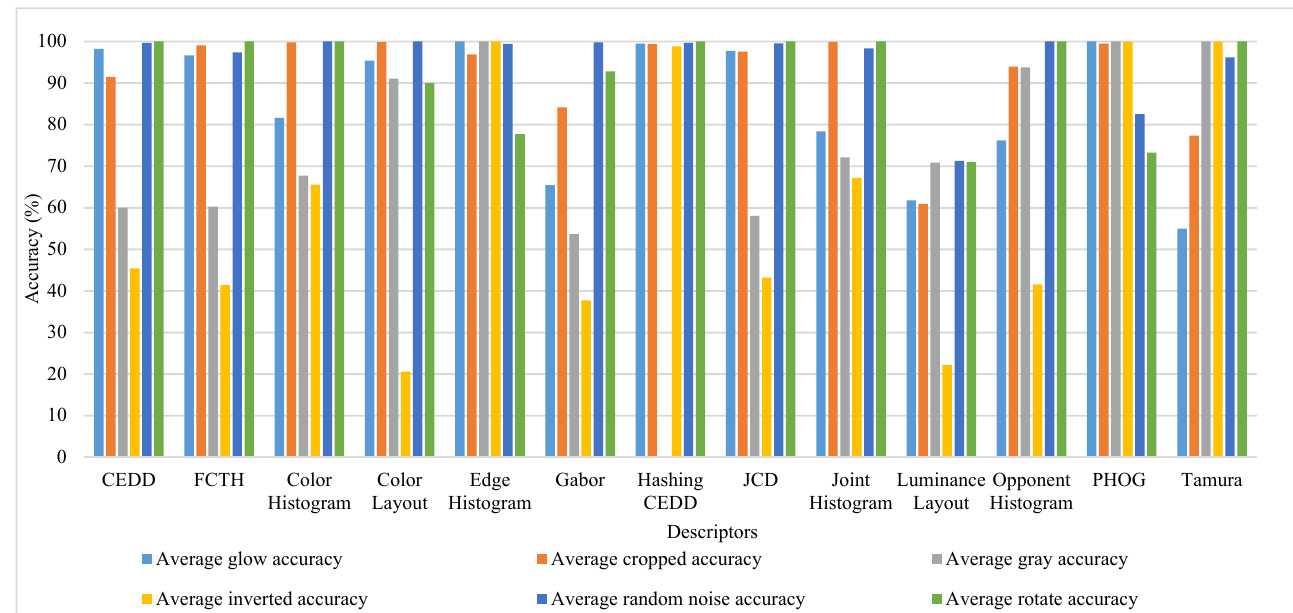
Figure 21. Comparing all descriptors from a viewpoint which relates all filters per descriptor.